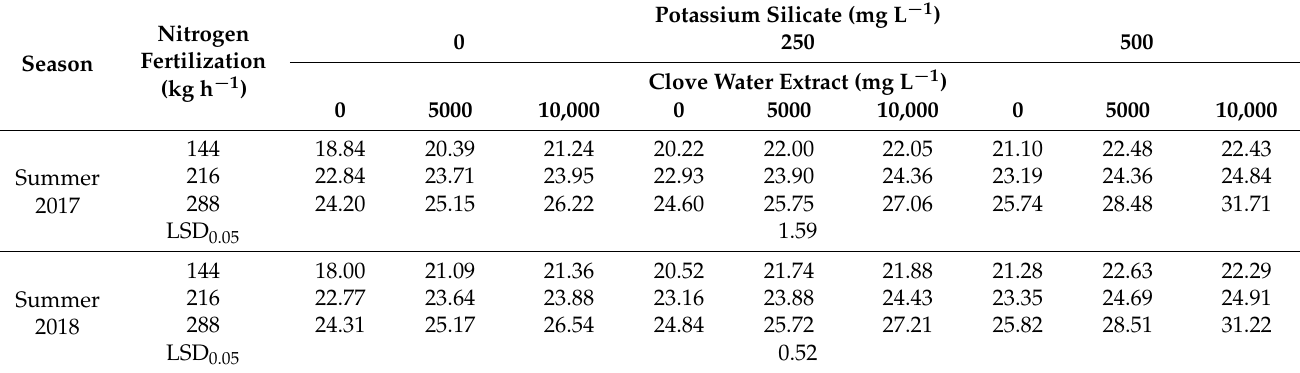
Table 6. Means of fruit total yield (t ha –1 ) as affected by the nitrogen fertilization × potassium silicate during 2017 and 2018.